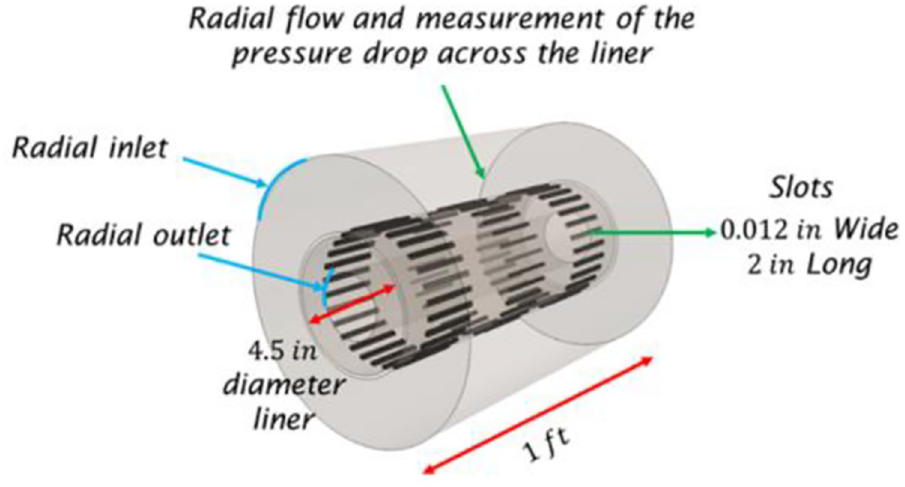
Fig 4. Schematic of the small section of the completion liner used to calculate the viscous and inertial resistance to simulate this liner as a porous region.